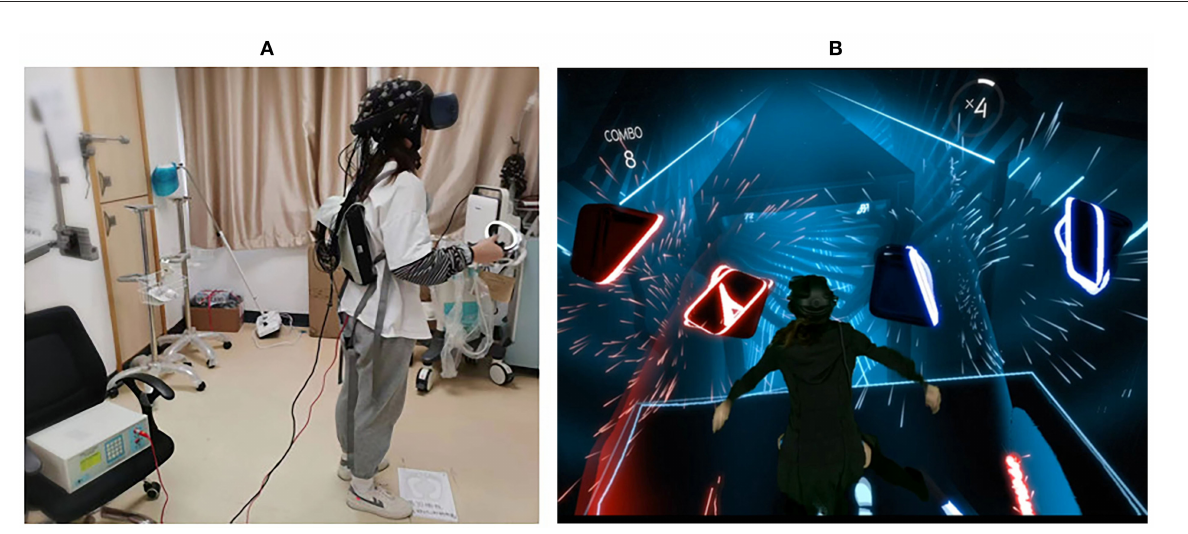
parietal, temporal, and occipital regions at both